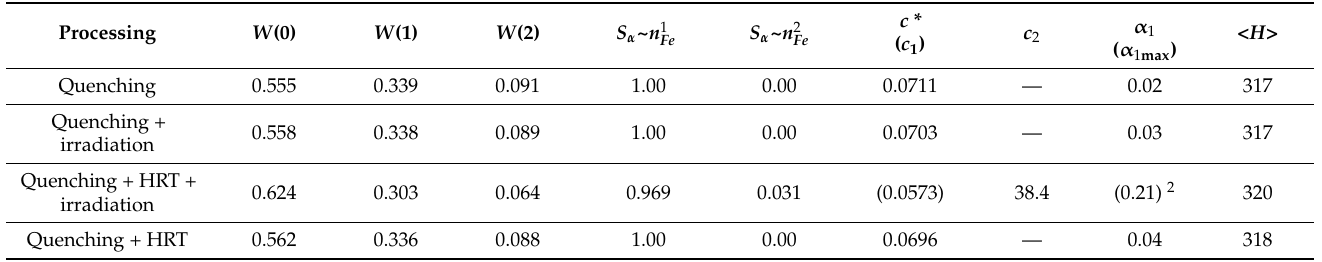
Table 1. Results of the analysis of the Mössbauer spectra of the Fe-7.25 at.% Mn alloy after various types of processing.